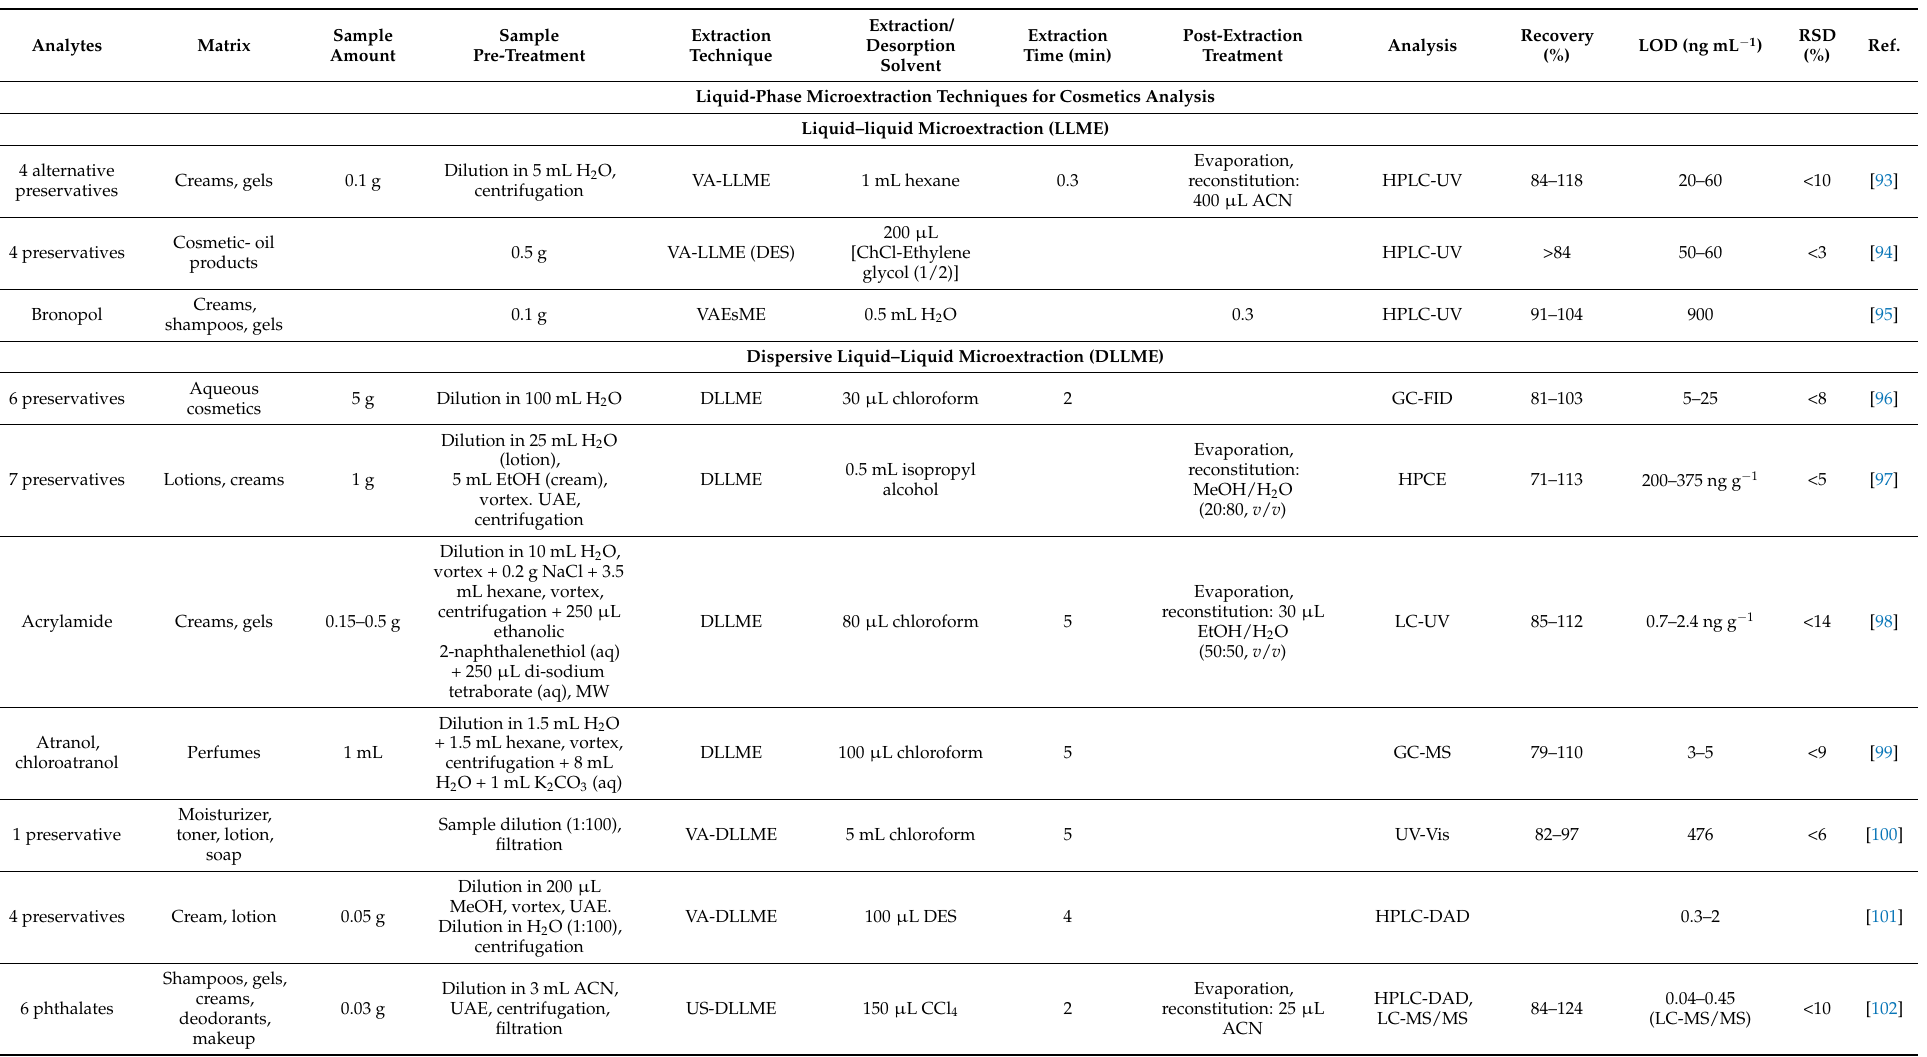
Table 2. Microextraction techniques for cosmetics analysis. Liquid-phase (LLME, DLLME, USAEME) and sorbent-based (SPME, FPSE, SBSDME) methodologies.